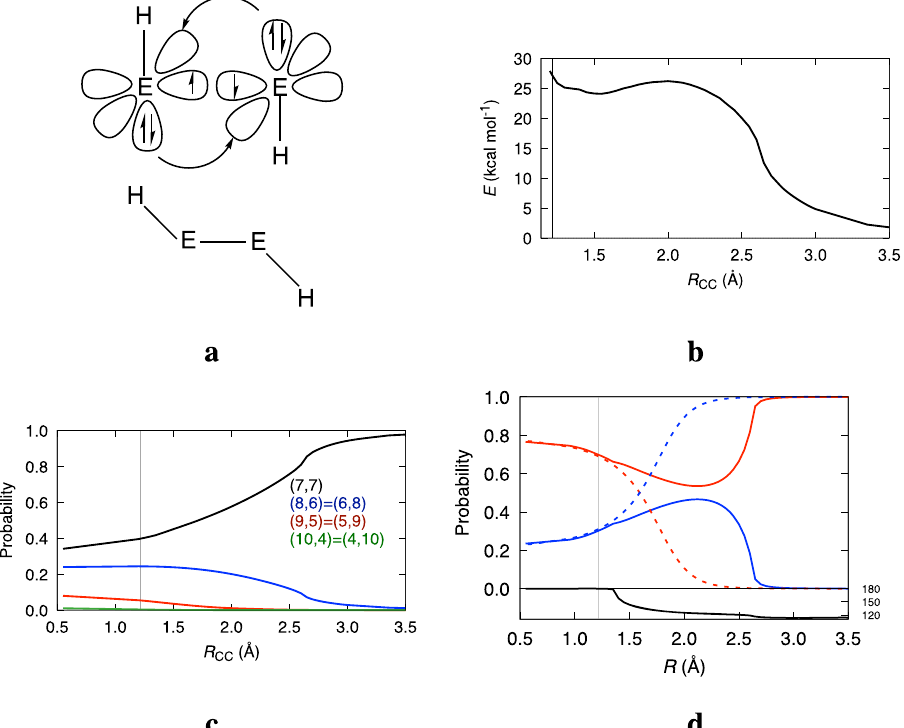
Fig. 5 Spatial partitioning in acetylene. CASSCF/def2-TVZPP data along the association process of two ground state 2 Π CH fragments to form acetylene. a Chemical bonding model explaining the trans geometry path. b E def of the CH fragment. c Probabilities of the (7, 7), (8, 6) = (6, 8), (9, 5) = (5, 9), and (10, 4) = (4, 10) electron partitions in black, blue, red, and green, respectively. d Normalized probabilities for the 2 Π and 4 Σ spin states of the (7, 7) CH fragment neutral distribution (red and blue lines), respectively. The equivalent probabilities for the 2 D + 2 S and 4 S states obtained for N 2 at the same level of theory are also drawn with the same colors but with dashed lines. The variation of the HCC angle along the process is found in the bottom panel. Vertical lines are drawn at the equilibrium distance.